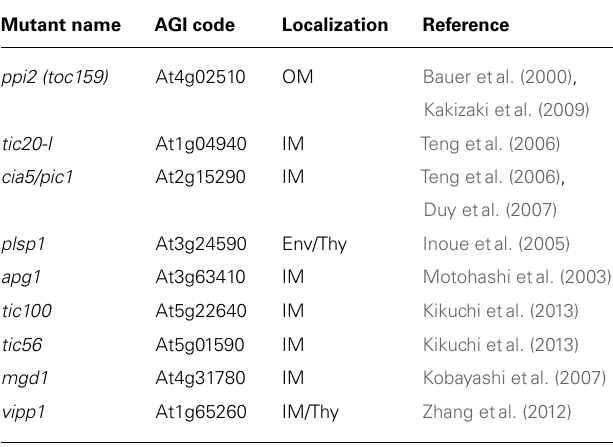
Table 2 | List of seedling lethal Arabidopsis mutants lacking an outer or inner envelope chloroplast membrane protein. Mutant